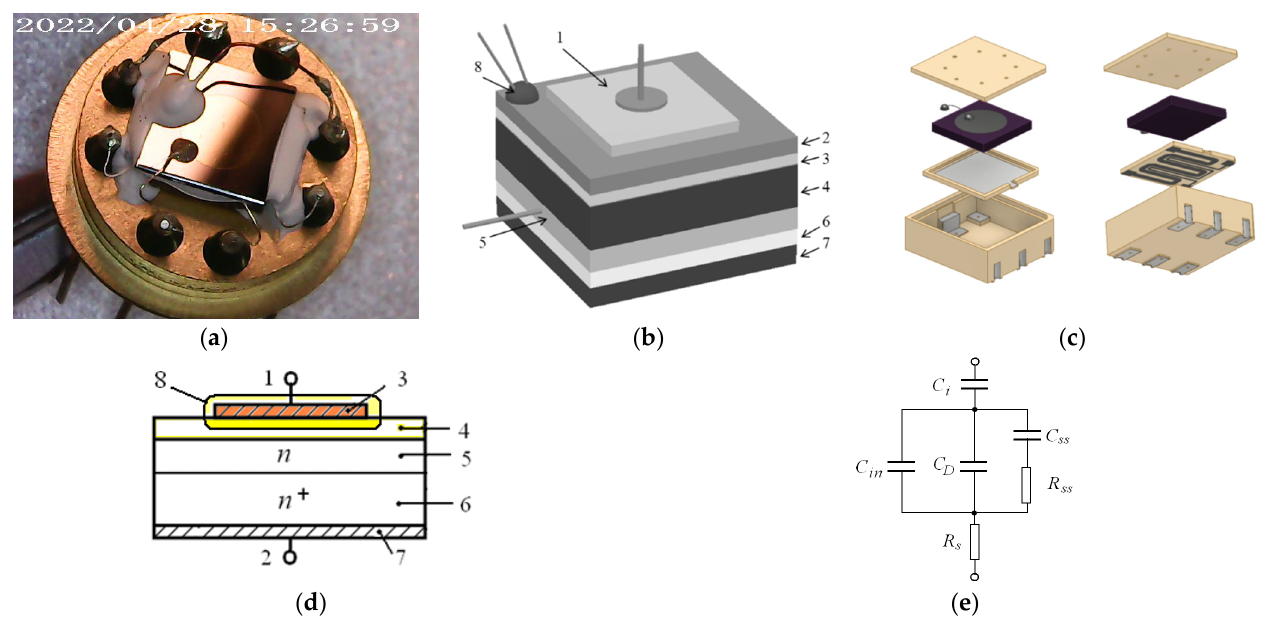
Figure 1. Field-effect gas sensor. ( a ) Image of the field-effect gas sensor based on a Si chip, assembled in the TO-8 package. ( b ) Schematic of the field-effect gas sensor based on a Si chip, assembled in the TO-8 package, including a capacitor, the substrate of which is an n-type silicon wafer “4” that is coated on one side with a SiO 2 “3” film and an additional Ta 2 O 5 “2” layer deposited on the dielectric by the laser deposition catalytic metal Pd “1”, to which an external metal electrode is glued. The second electrode is glued to the metal layer “5” deposited on the reverse side of the Si wafer. The gas-sensitive structure with a temperature-measuring thermistor “8” is located on an glass insulating plate “6” separating it from the film resistive heater “7”. ( c ) A 3D model of the metal–ceramic package layout: beige—ceramics from Al 2 O 3 , light and dark gray—silver and platinum metallization, violet—Si crystal. ( d ) The simplest structure of a field-effect capacitor gas sensor based on an n-type semiconductor: “1“—working electrode lead of “3”, “2”—lead of Ohmic contact “7”, “4”—thin dielectric film (50–200 nm thick), “5”—high-resistance Si region (donor concentration: N D < 10 16 cm − 3 ), “6”—low-resistance semiconductor region (concentration: N D > 10 18 cm − 3 ), “8”—gas-sensitive region. ( e ) Simplified equivalent electrical circuit field-effect gas sensor based on a Si chip.